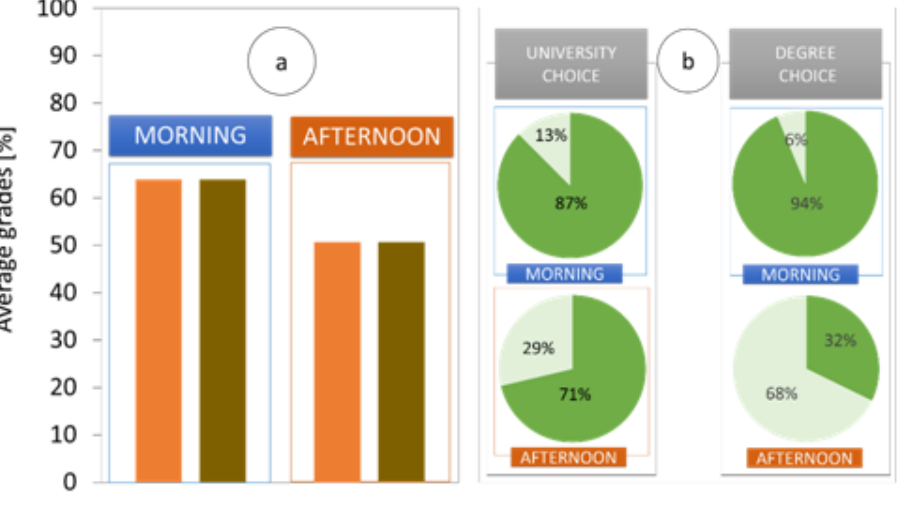
Figure 10. a) Average grades as a function of the time slot: Tasks and Exam; b) Overview of the diagnostic survey results: UB and Degree as the first choice and UB and Degree not the first